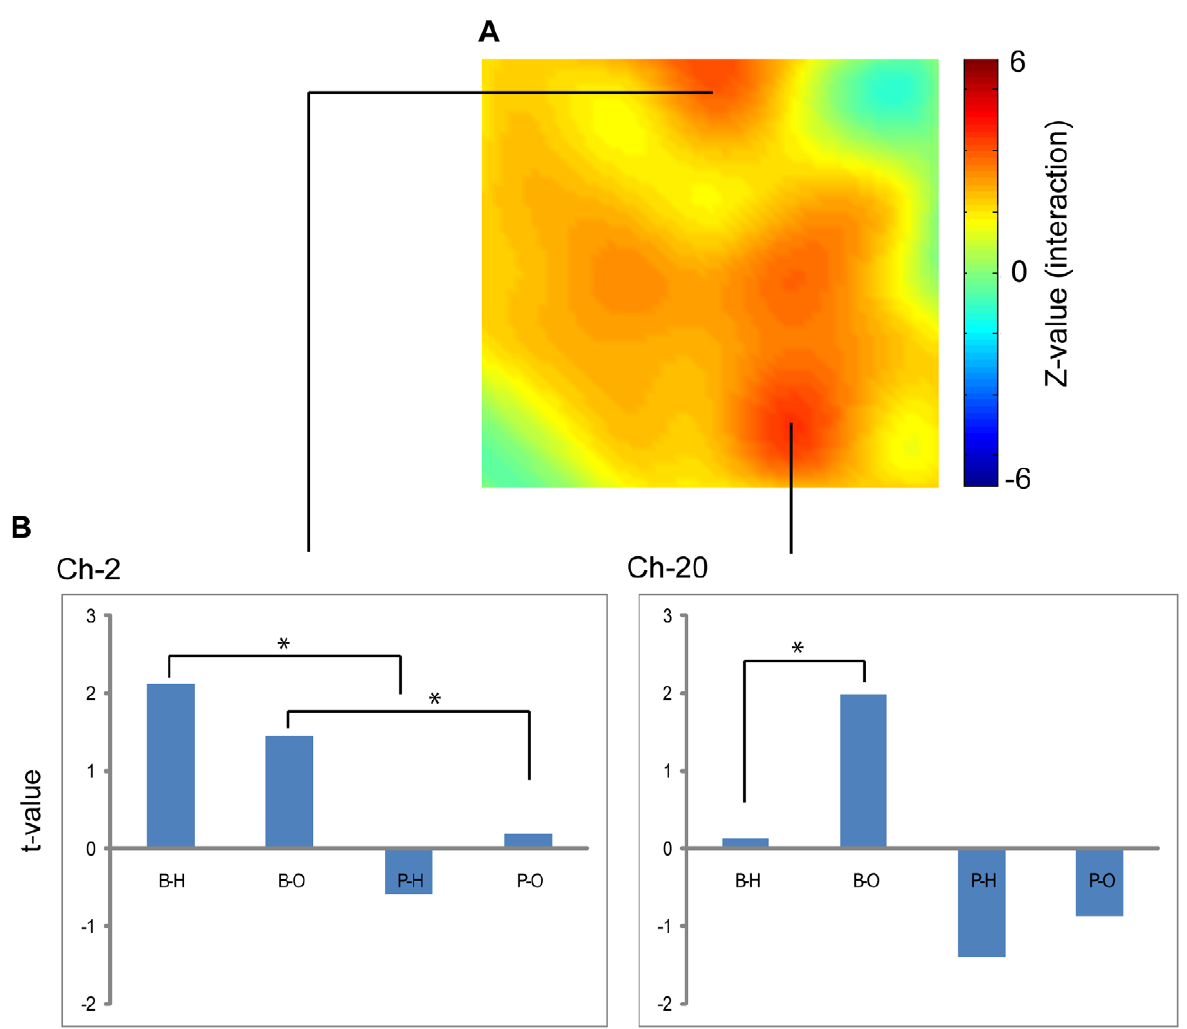
Figure 2. Results of NIRS measurement. A. Z-map (oxy-Hb) of channels that showed an interaction between appearance and kinematics factors thresholded at P , 0.05 (corrected). B. Z-values for each condition contrasted against the control period calculated by GLM analyses at ch-2 and ch-20. B-H, Batter-Hit; B-O, Batter-Out; P-H, Pitcher-Hit; P-O, Pitcher-Out conditions.